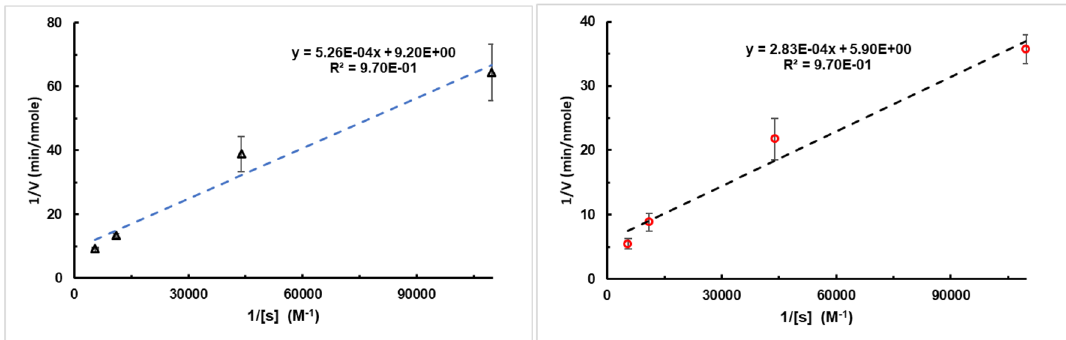
Figure 4. Double reciprocal plot of kinetics data, RF heated sample at 50 W is in red circles (right), without RF at the same temperature is the black triangles (left). From the intercept and slope we determined K m and V max and k cat using the Michaelis–Menten model of enzyme kinetics. Error bars represent uncertainty in the slopes.